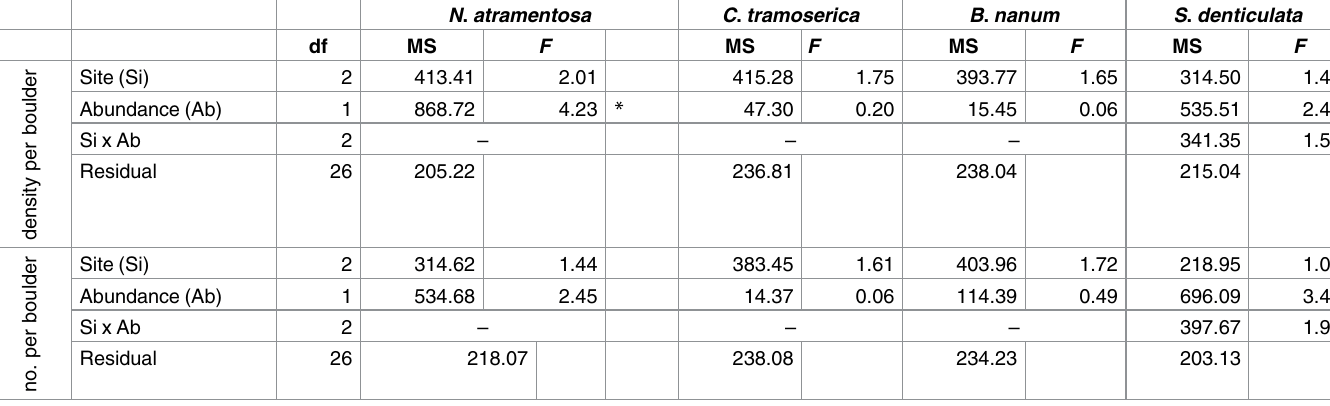
Table 4. Density of the grazer Nerita atramentosa is significantly correlated with cover of Ulva algae.